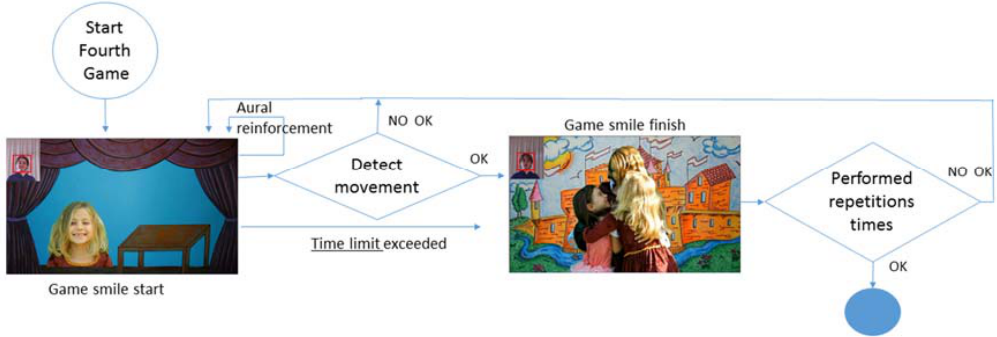
Figure 9. Activity diagram: smiling game.